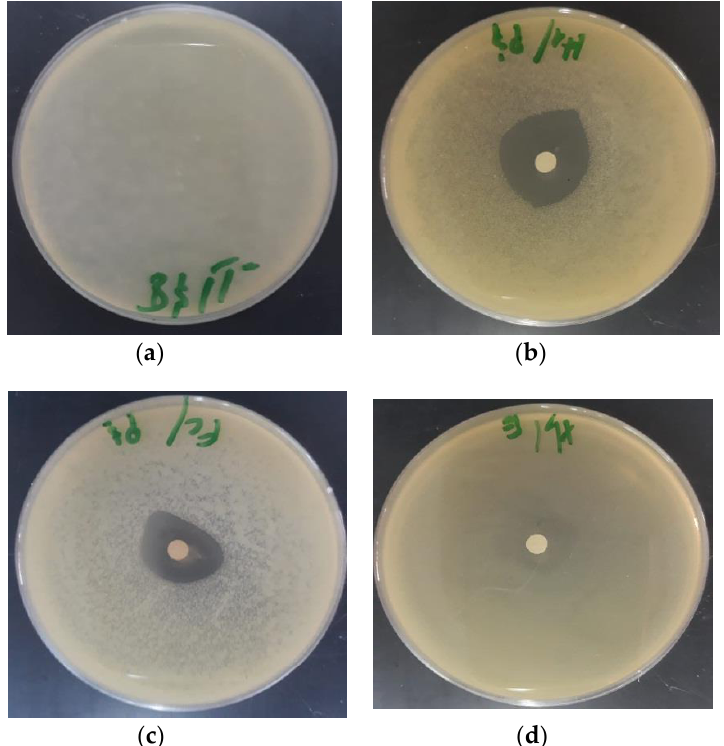
Figure 5. Photographs showing inhibition zones against bacteria. ( a ): negative control; ( b ): B. subtilis ; ( c ): E.coli ; ( d ): positive control. Table 2. Antibacterial power of EOAG as assessed by use of inhibition zone diameters and MIC assays.